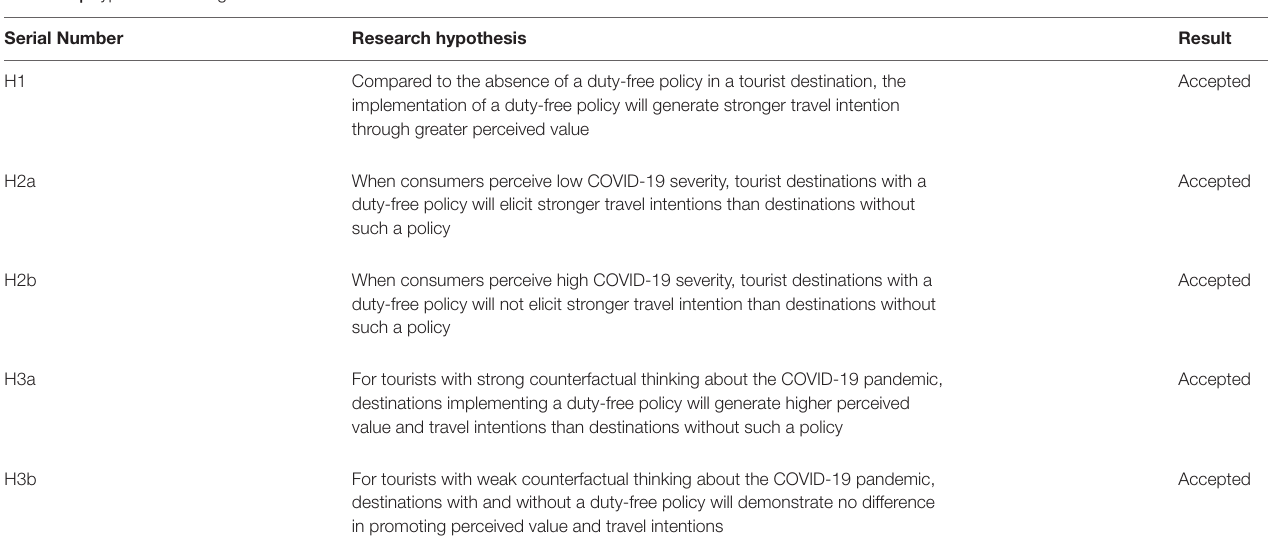
TABLE 7 | Hypothesis testing